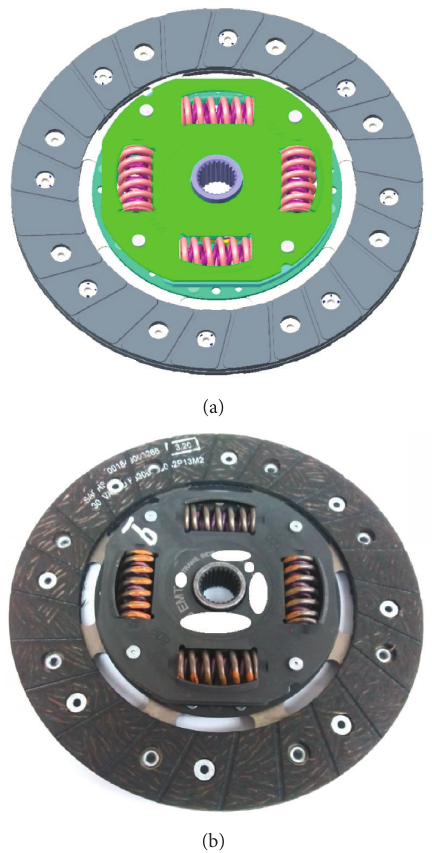
Figure 20: A two-stage stiffness clutch damper adopted in the model: (a) 3D model, (b) physical model.